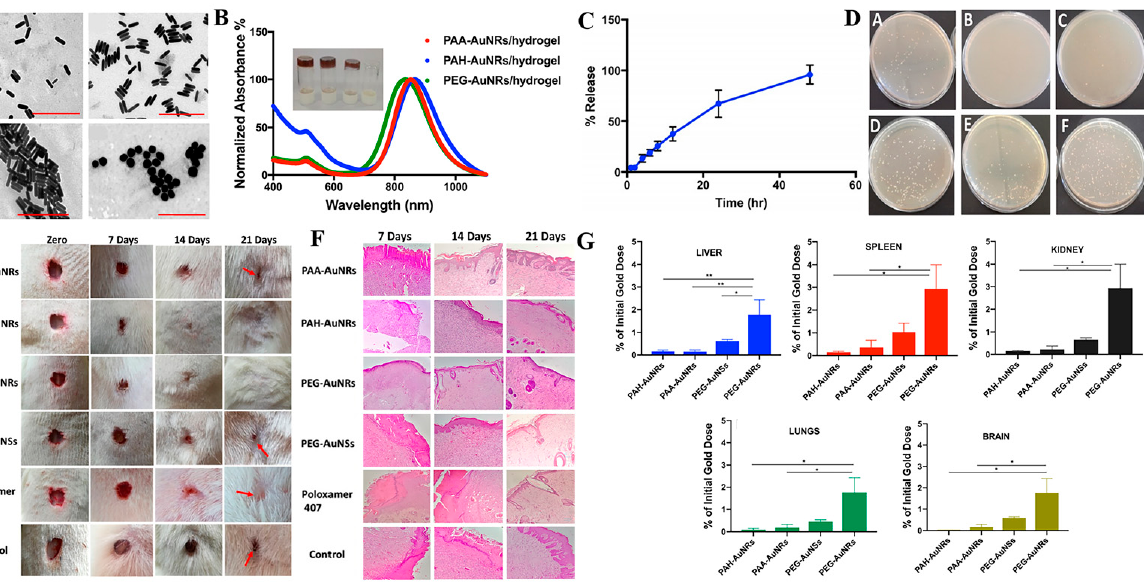
Figure 3. ( A ) TEM images of AuNPs showing different sizes and surface modifications. ( B ) UV-vis absorption spectra and photos of AuNRs-hydrogels with different surface modifications. ( C ) In vitro release curve of AuNRs from the PEG-AuNRs loaded poloxamer 407 hydrogel. ( D ) Overnight bac- terial cultures of wound-contacted swaps after 14 days of wound treatment by different hydrogels. ( E ) Photographs and ( F ) H&E histological examination of rat wounds after treatment by